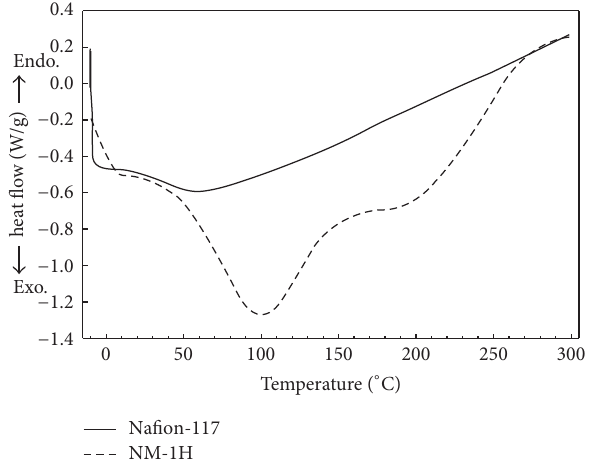
Figure 6: DSC thermogram of N-117and NM-1H modified mem- branes, in a nitrogen atmosphere at a heating rate of 10 ∘